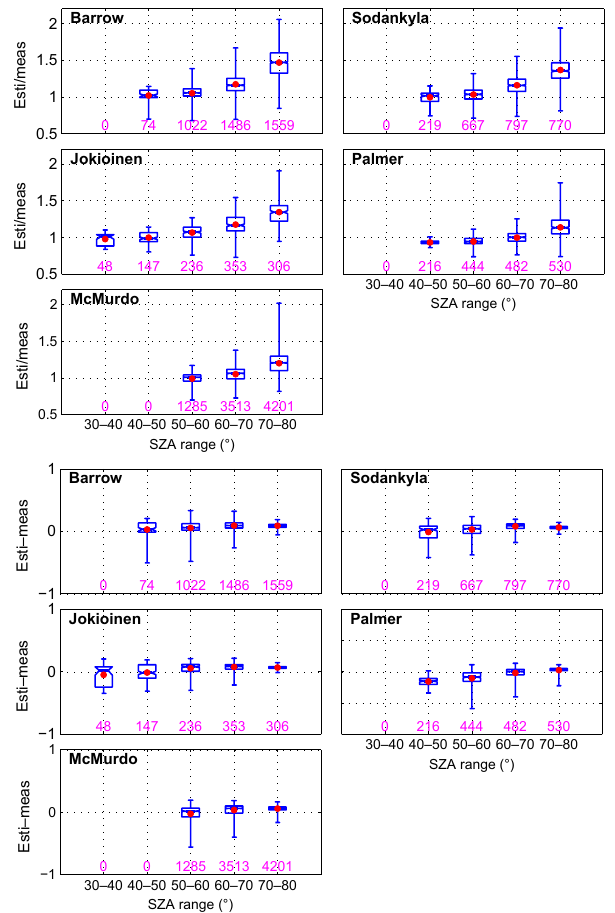
Figure 5. Same as Fig. 3, but for UV-B